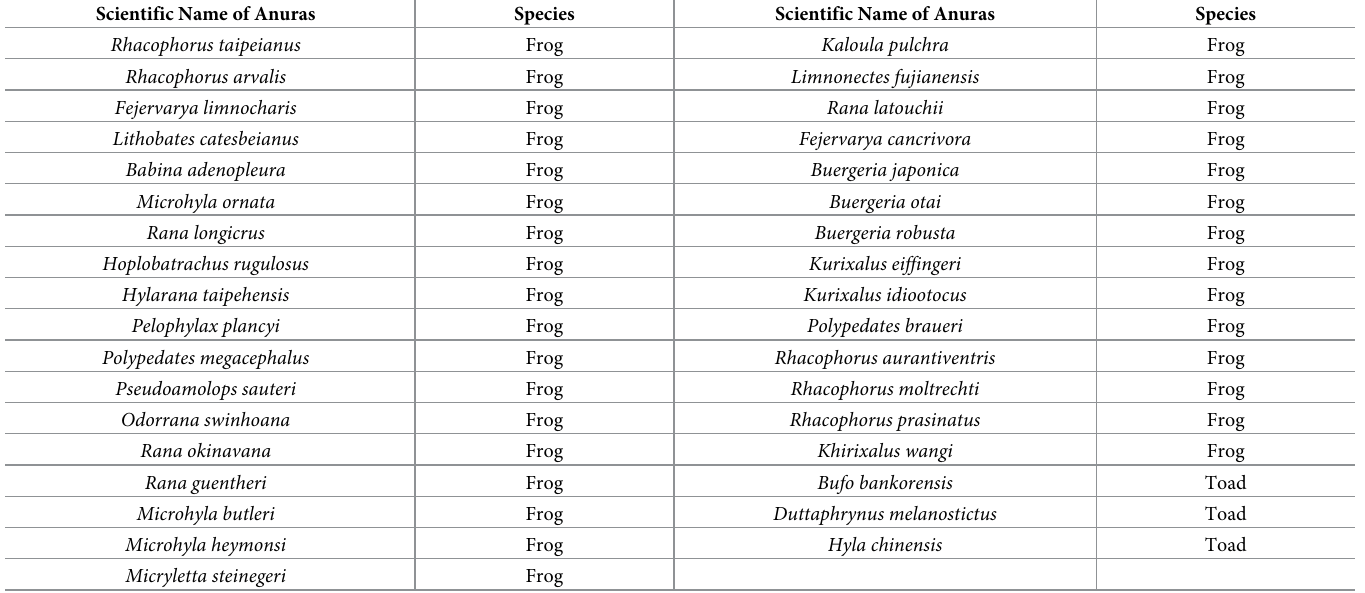
Table 1. Anuran species for